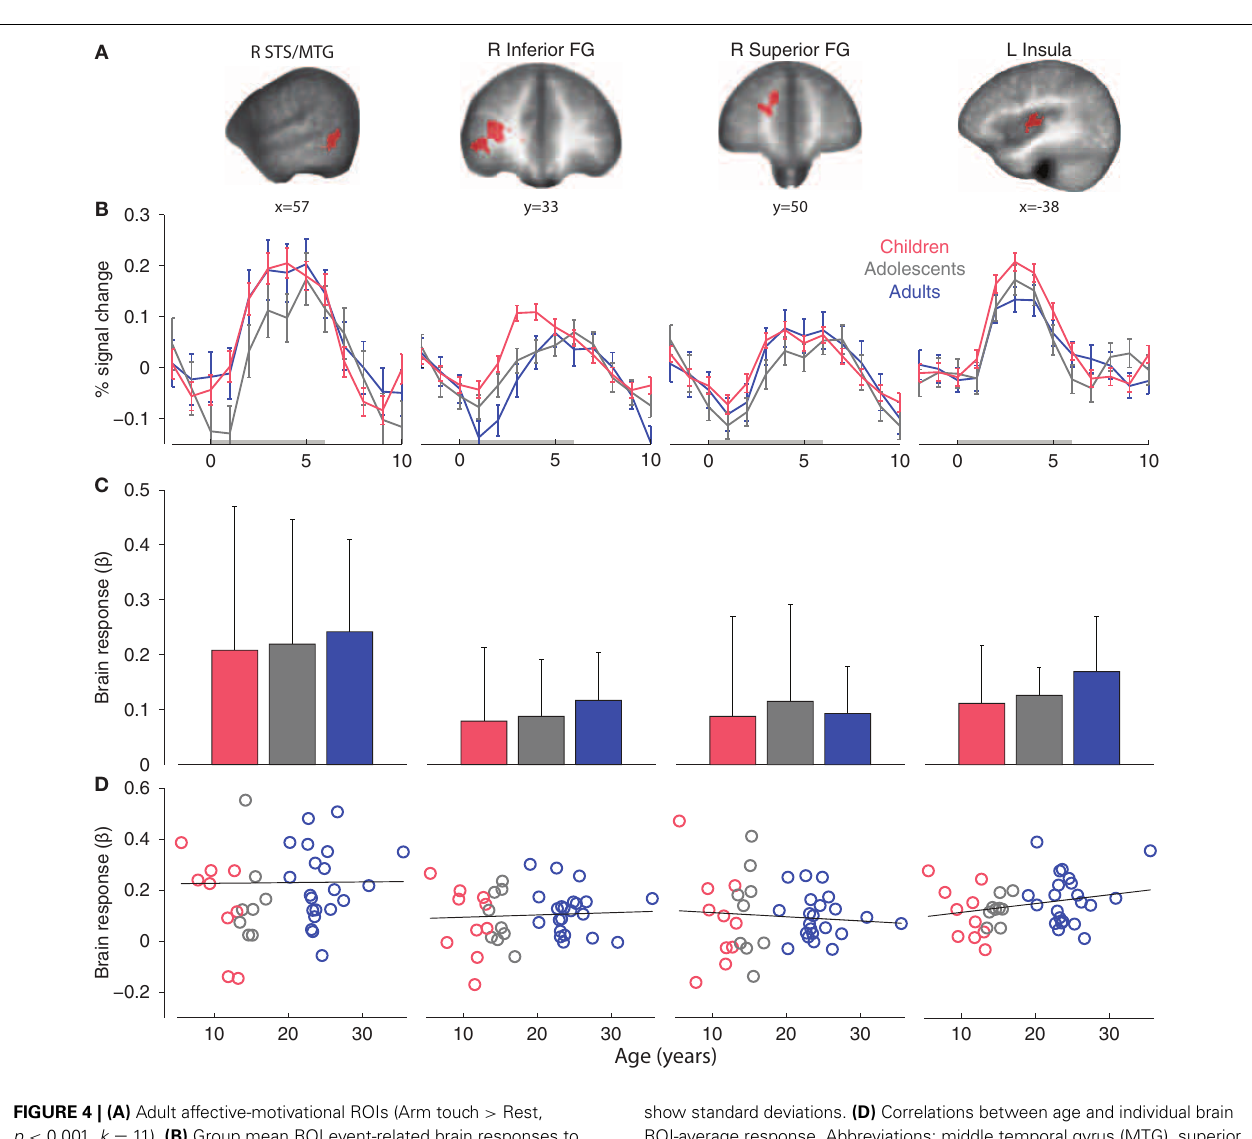
FIGURE 4 | (A) Adult affective-motivational ROIs (Arm touch > Rest, p < 0 . 001, k = 11). (B) Group mean ROI event-related brain responses to Arm touch. (C) Group mean ROI-average brain responses. The error bars